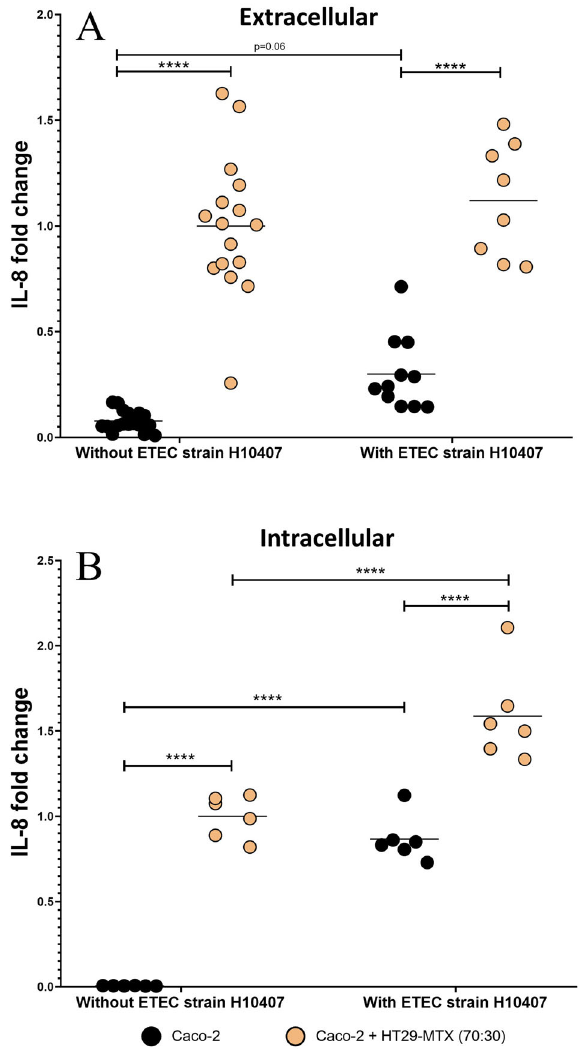
Fig. 4 ETEC induction of Interleukin-8 production by mucin secreting or non-secreting intestinal cells. Interleukin-8 (IL-8) extracellular secretion ( A ) and intracellular production ( B ) by ETEC- infected Caco-2 (black dots) or Caco-2/HT29-MTX (orange dots) cells were measured by an ELISA assay. Intestinal cells were infected for a 3-hour period with 10 7 CFU.mL − 1 (MOI 100) with ETEC strain H10407. Control experiments were performed without the bacteria. Results are expressed as fold changes compared to non-infected Caco-2/HT29-MTX cells. The data represents the replicates of at least 3 independent experiments with their means (black line). Statistical differences provided by Tukey ’ s multiple comparisons test are indicated (**** p <